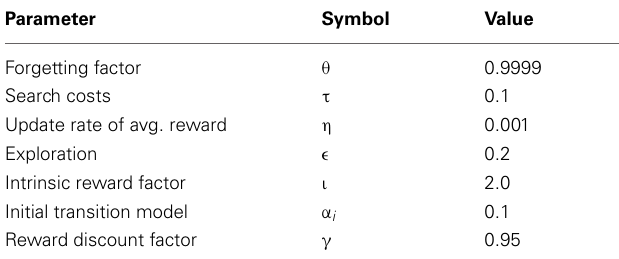
Table 2 | Default parameters that were used in the Playroom task unless noted